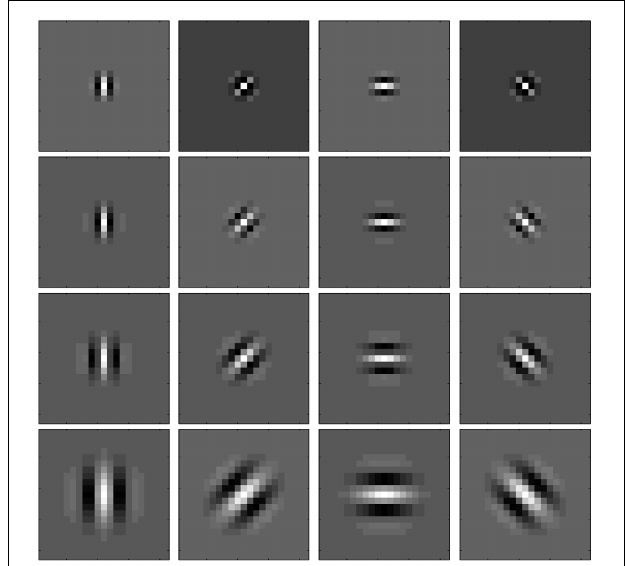
FIGURE 11 | Kernels used for the 4-orientation configuration. Each row represents a different scale (from smaller to larger kernels). The maximum kernel value is 15 and the minimum is − 7. Kernel size is 11 × 11 pixels.